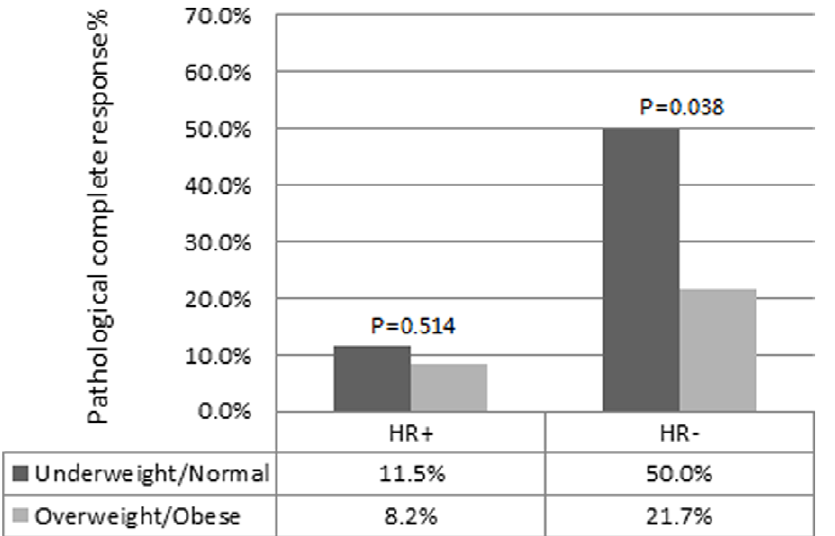
Figure 2. Probability of pathological complete response according to hormonal receptor status and BMI category. HR, hormonal receptor; HR + , ER + or PR + ; HR 2 , ER 2 and PR 2 .